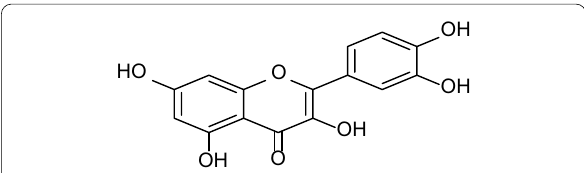
Fig. 1 Chemical structure of